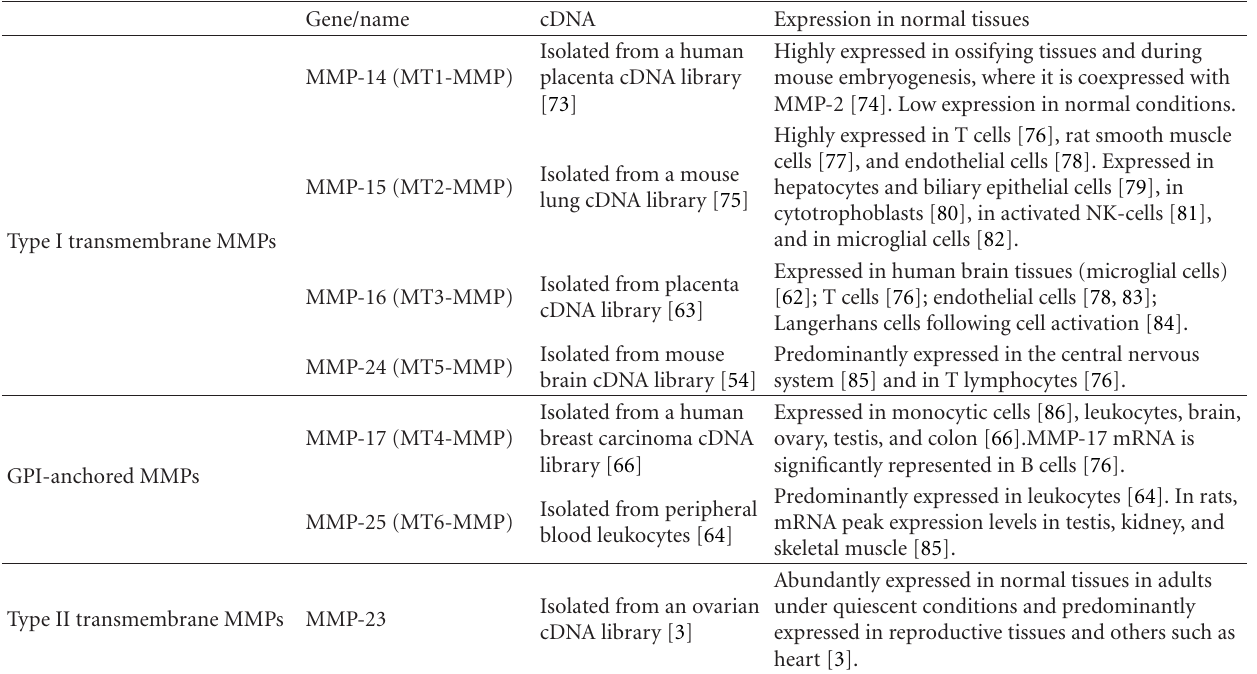
Table 2: Expression of membrane-bound MMPs in normal